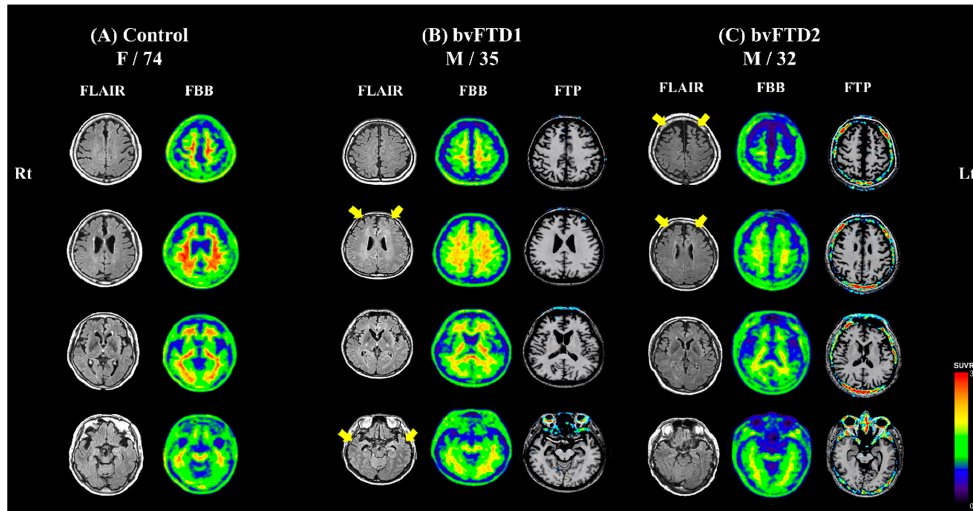
Figure 1. Brain images of participants. Axial views from top (in the first row) to bottom (in the